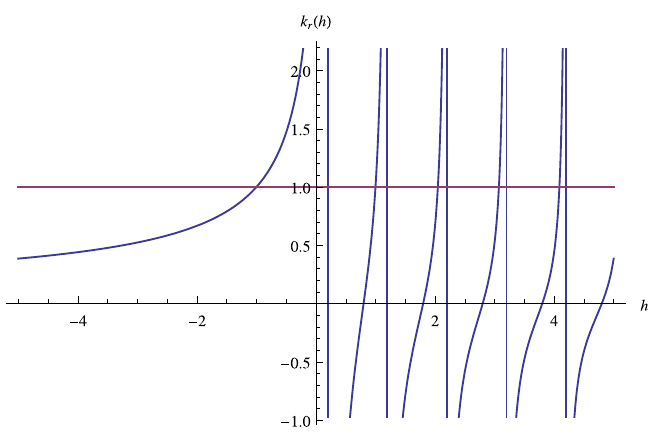
Figure 8 . Eigenvalues of the retarded kernel at ˆ q =